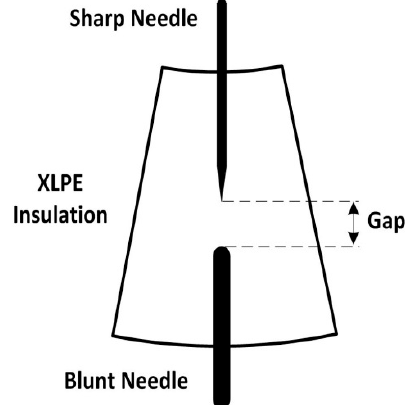
Figure 2. Electrodes arrangement in the test sample.